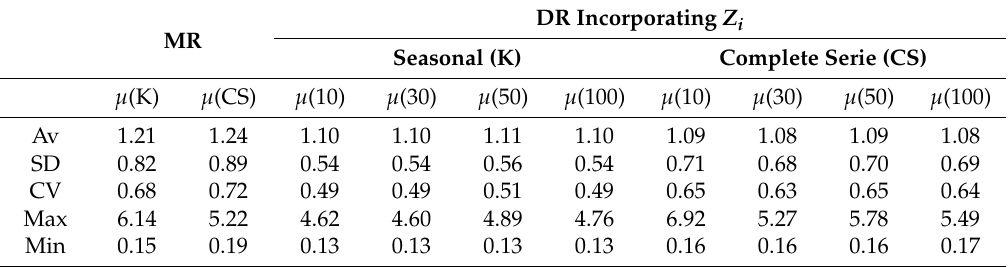
Table 4. Main statistical values for remaining errors ( µ ) according to multiple regression (MR) and dynamic regression (DR) analysis. Av: Average; SD: standard deviation; CV: coefficient of variation; Max: maximum value; Min: minimum value; K: seasonal; CS: complete series; µ ( i ) , with i soil